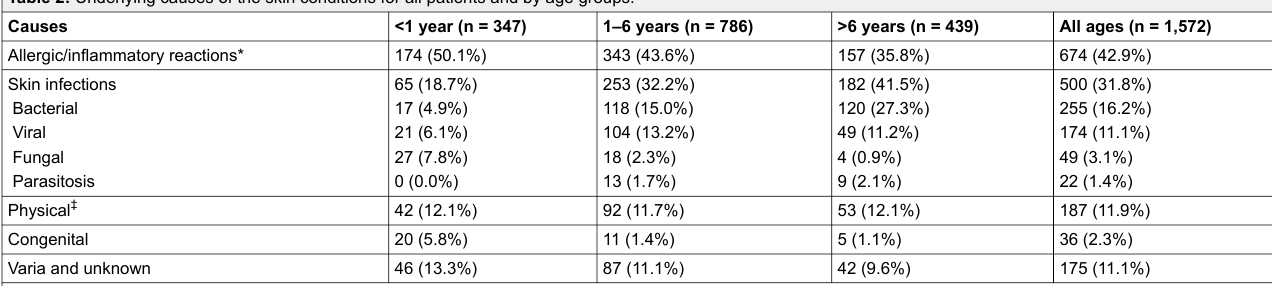
Table 2: Underlying causes of the skin conditions for all patients and by age groups.